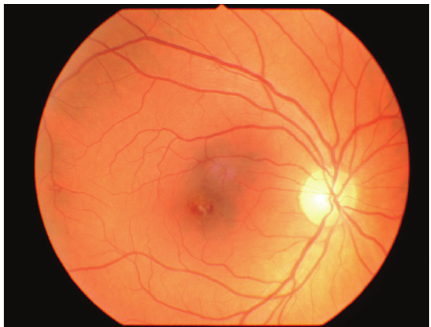
Figure 1: Color fundus photograph of the right eye showing central macular Roth spot.